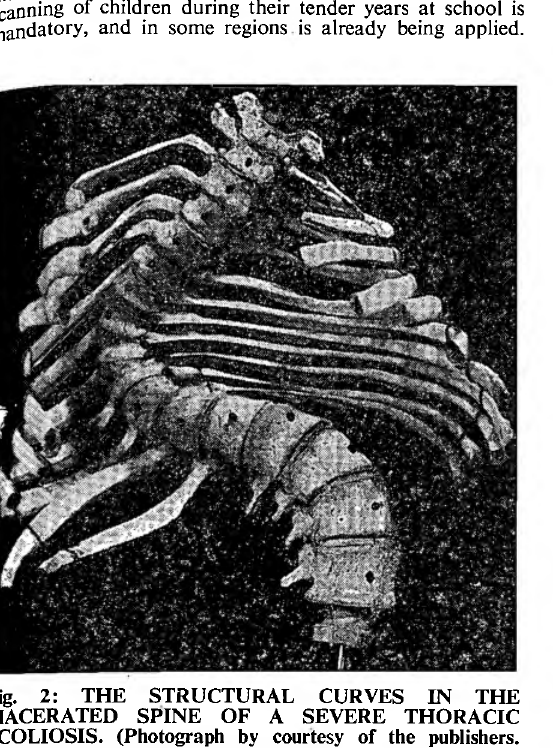
Fig. 2: THE STRUCTURAL CURVES IN THE MACERATED SPINE OF A SEVERE THORACIC SCOLIOSIS. (Photograph by courtesy of the publishers. Messrs. E. & S. LIVINGSTONE LTD., LONDON, M67, and of • the J author. REFERENCE: Monograph entitled ‘SCOLIOSIS’. AUTHOR: J. I. P. .TAMES. (Note: The black marker dots have been added by the present author.)